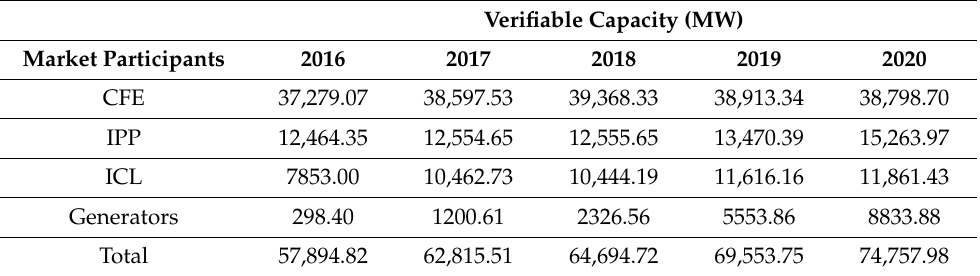
Table 1. Capacity available for energy production per market participant from 2016 to 2020.